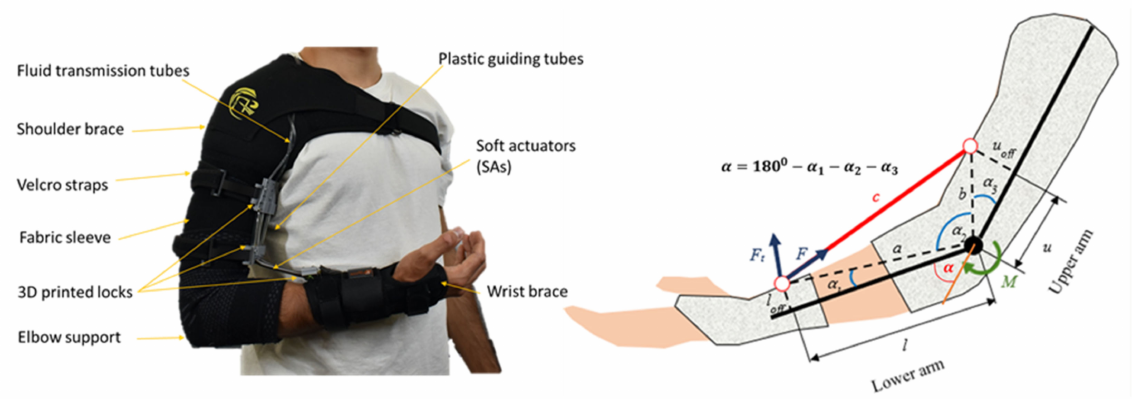
Figure 6. The soft robotic fabric sleeve attached to the elbow ( left ) and its kinematics ( right